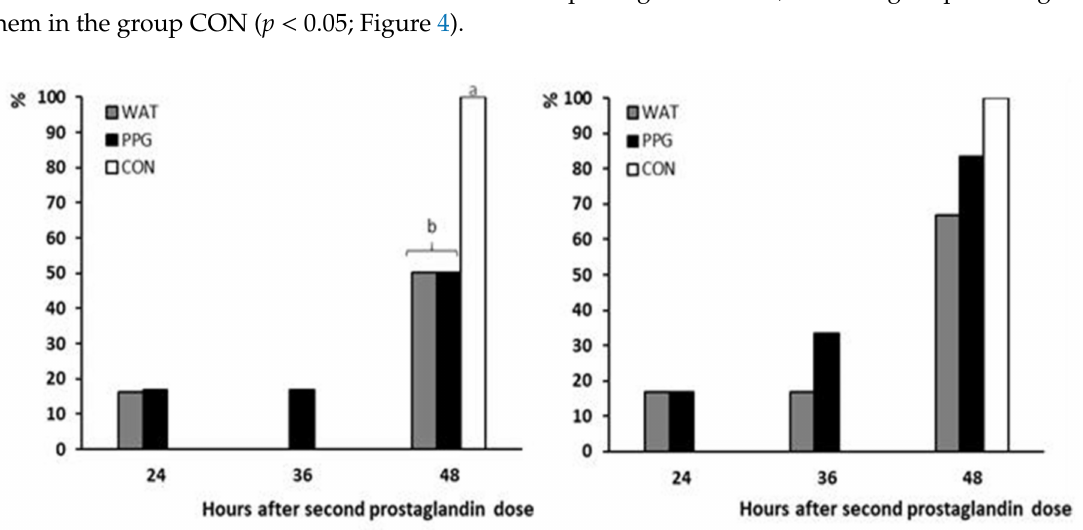
Figure 4. Absolute (left panel) and cumulative (right panel) percentages of sheep showing onset of estrus after treatment with two doses of PGF 2 α and a single dose of distilled water (group CON; white bars) or 50 µ g of GnRH in either distilled water (group WAT; grey bars) or propylene-glycol (group PPG; black bars) at 32 h after the second PGF 2 α dose. Di ff erent superscripts indicate significant di ff erences among treatments (a (cid:44) b: p <